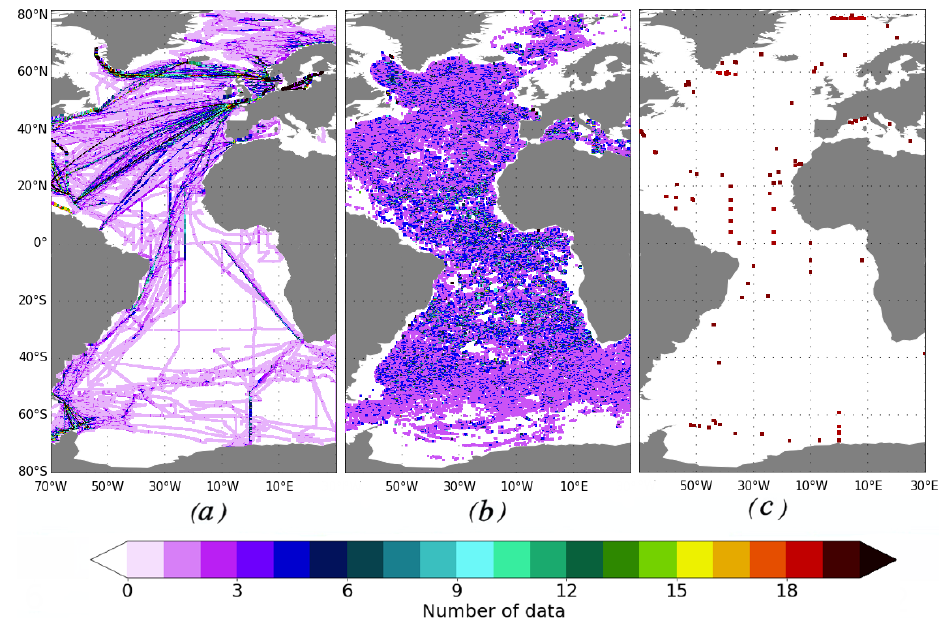
Figure 1. Spatial distribution of datasets used for training (number of measurements per grid point and 5d time step): (a) SOCAT data for the period 2001–2010, (b) synthetic Argo data for the period 2008–2010, and (c) mooring positions modelled for the period 2008–2010. Table 1. Information on Observation System Simulation